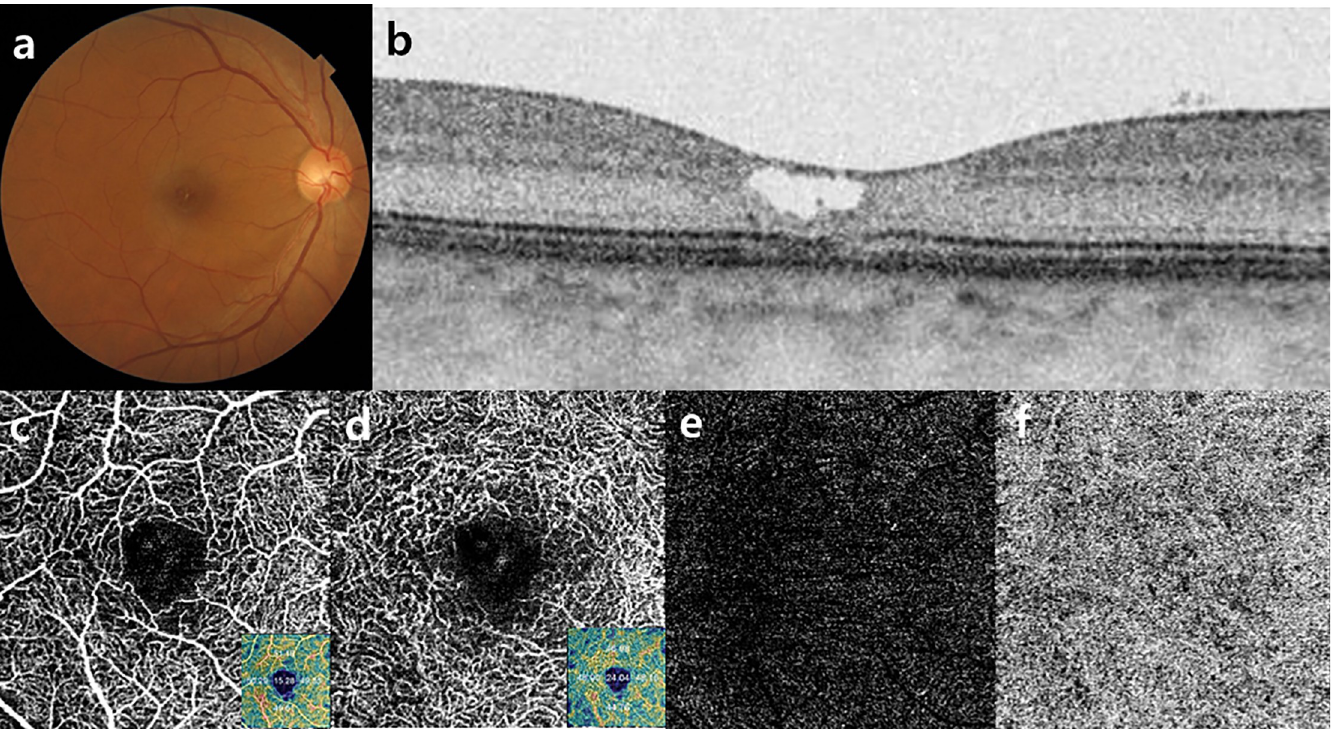
Fig 2. Representative images of an eye with MacTel 2. (a, b) Fundus photograph showing loss of retinal transparency from the temporal side to the fovea and focal loss of the ellipsoid zone on spectral domain optical coherence tomography images. (c–f) Vascular density map of an eye with MacTel 2 with optical coherence tomography angiography (c, superficial capillary plexus; d, deep capillary plexus; e; outer retina; f, choriocapillaris).